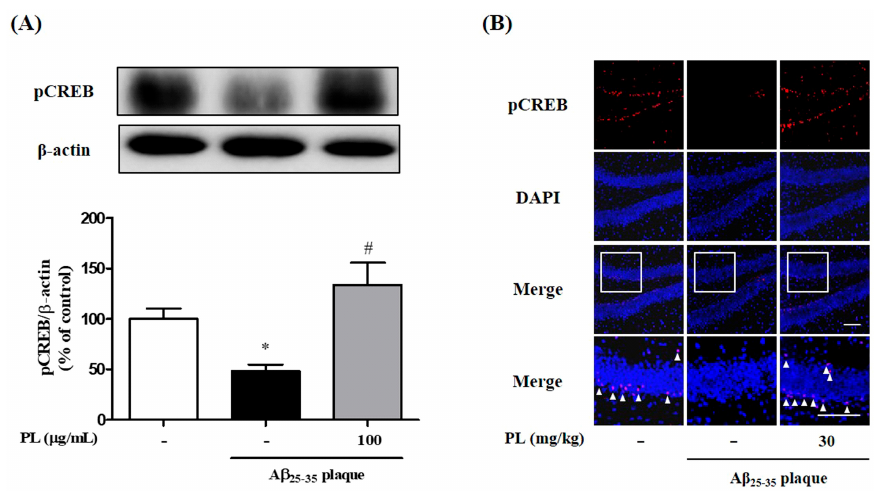
Figure 5. Effect of PL on phosphorylation of cyclic AMP response element-binding protein (CREB) in A β 25–35 plaque-stimulated HT22 cells and mice. Cells were treated with PL (100 µ g/mL) for 1 h and incubated with A β (10 μ mol/L) for a further 23 h. Cell lysates were assessed by Western blot using pCREB antibody. ( A ) Quantification of pCREB protein was normalized to β -actin. After stereotaxic injection of A β 25–35 plaque, mice were treated with vehicle or PL for 17 days; ( B ) pCREB expression was explored in the dentate gyrus (DG). Scale bar = 100 μ m. Values are mean ± standard error of the mean. * p < 0.05 vs. control group; # p < 0.05 vs. A β 25–35 plaque group. The arrowheads in magnified images point to pCREB/4’,6-diamidino-2-phenylindole (DAPI) double-labeled neurons.